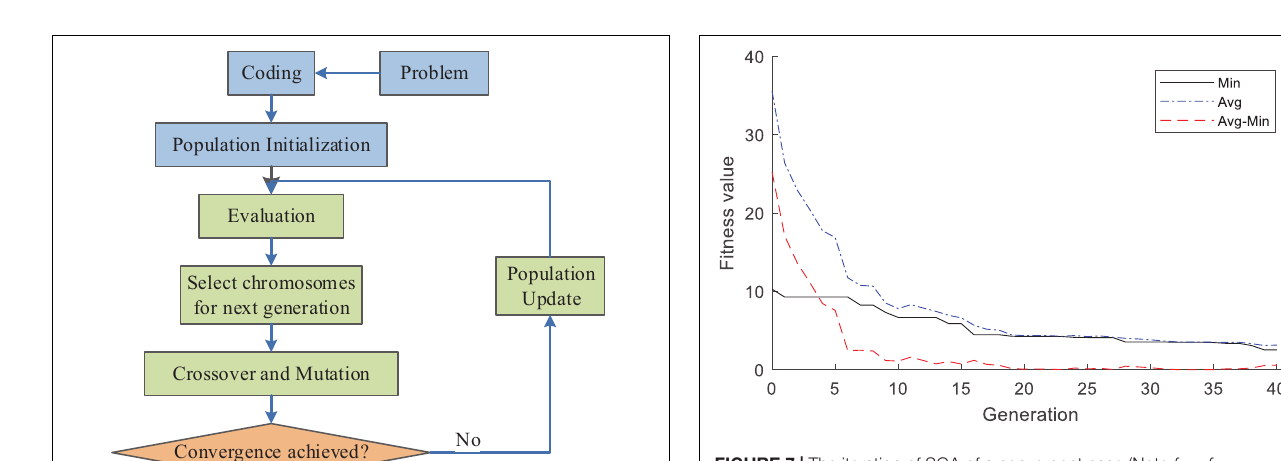
FIGURE 5 | Encoding scheme.